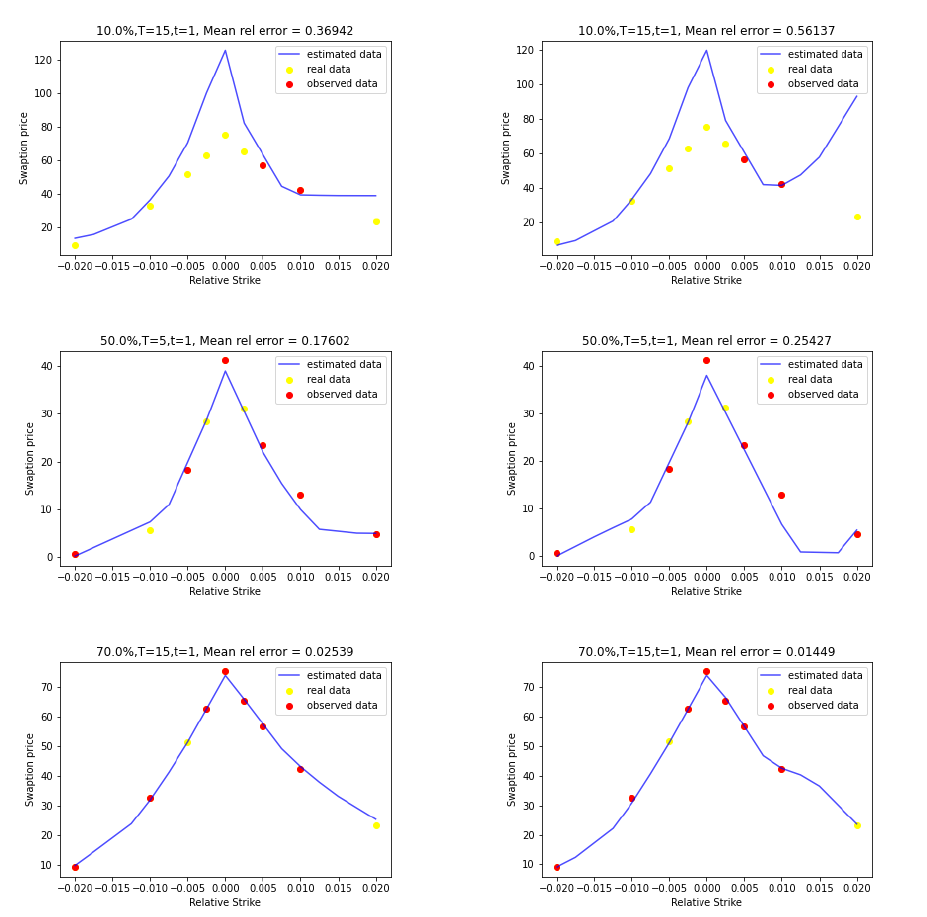
Figure 1. Constrained GP ( left ) and unconstrained GP ( right ) price curves for p = 10% ( top ), p = 50% ( middle ) and p = 70% ( bottom ).